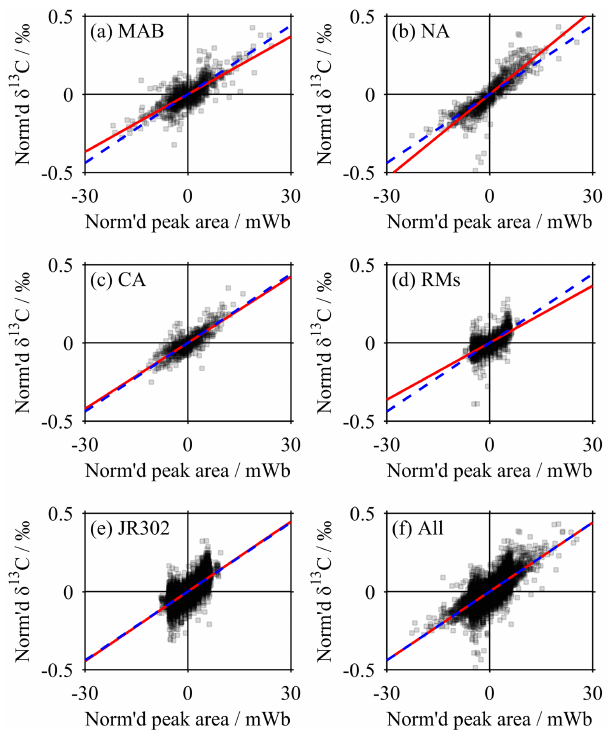
Figure 3. The peak area correction relationship. All technical repli- cates are plotted, normalised such that the mean peak area and δ 13 C for each set of technical replicates are both 0 (‰ or mWb respec- tively). The red line is the same in each plot, showing the mean rela- tionship used for all of the peak area corrections, while each dashed blue line shows the equivalent relationship determined only from the data scattered in each panel. Individual data points are semi-